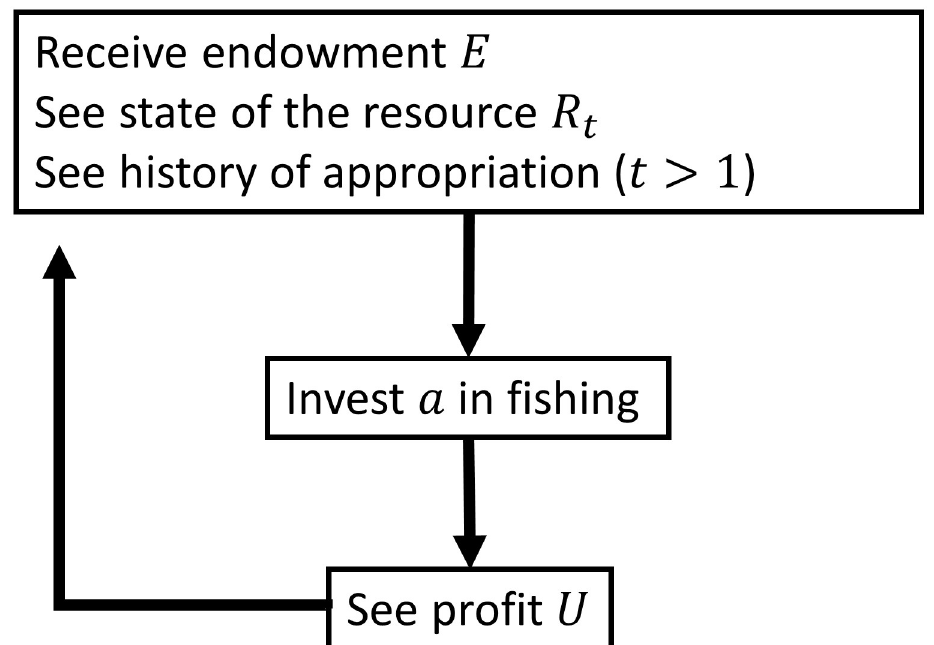
Fig 2. The different stages in a Fishing Game